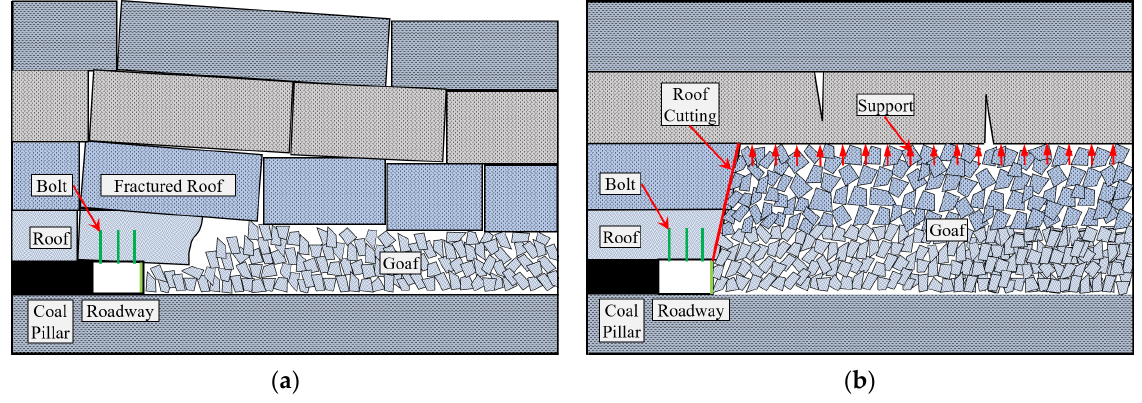
Figure 15. Rock strata fracture diagram: ( a ) traditional mining method; ( b ) roof cutting and pressure relief.